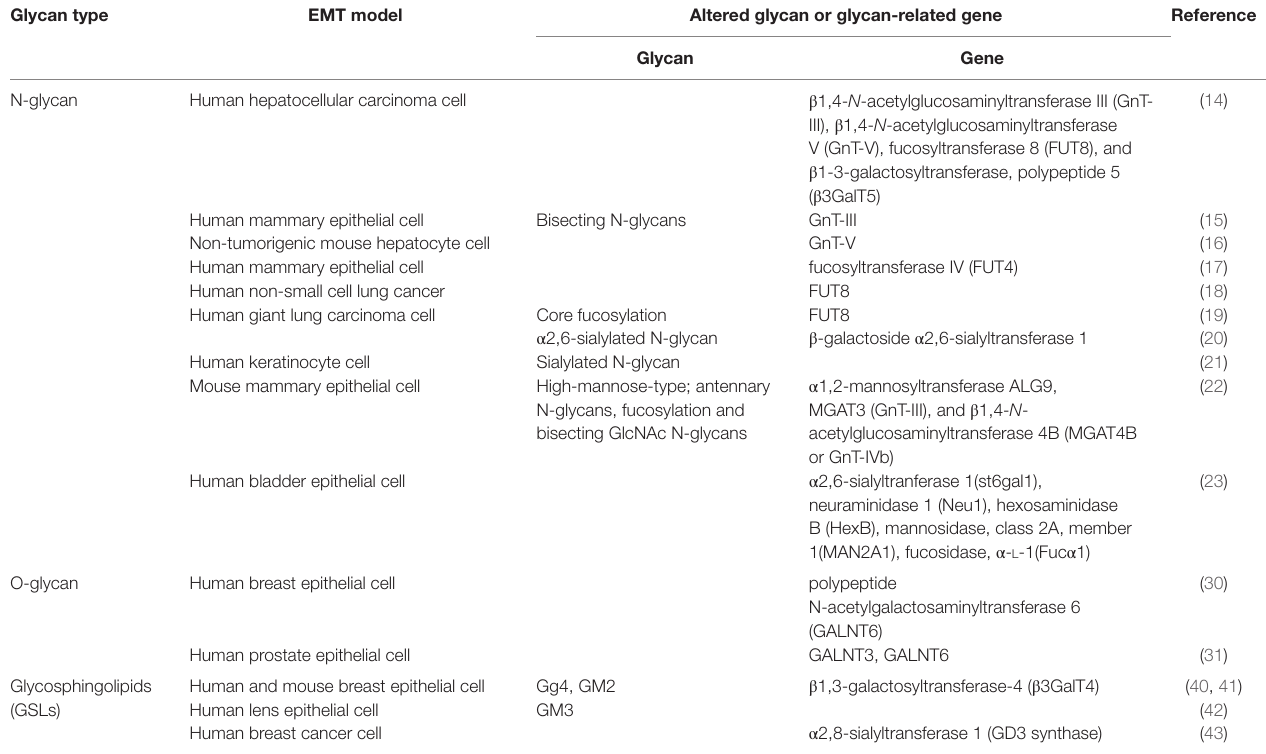
TABLe 1 | Altered glycans and glycan-related genes in eMT. Glycan